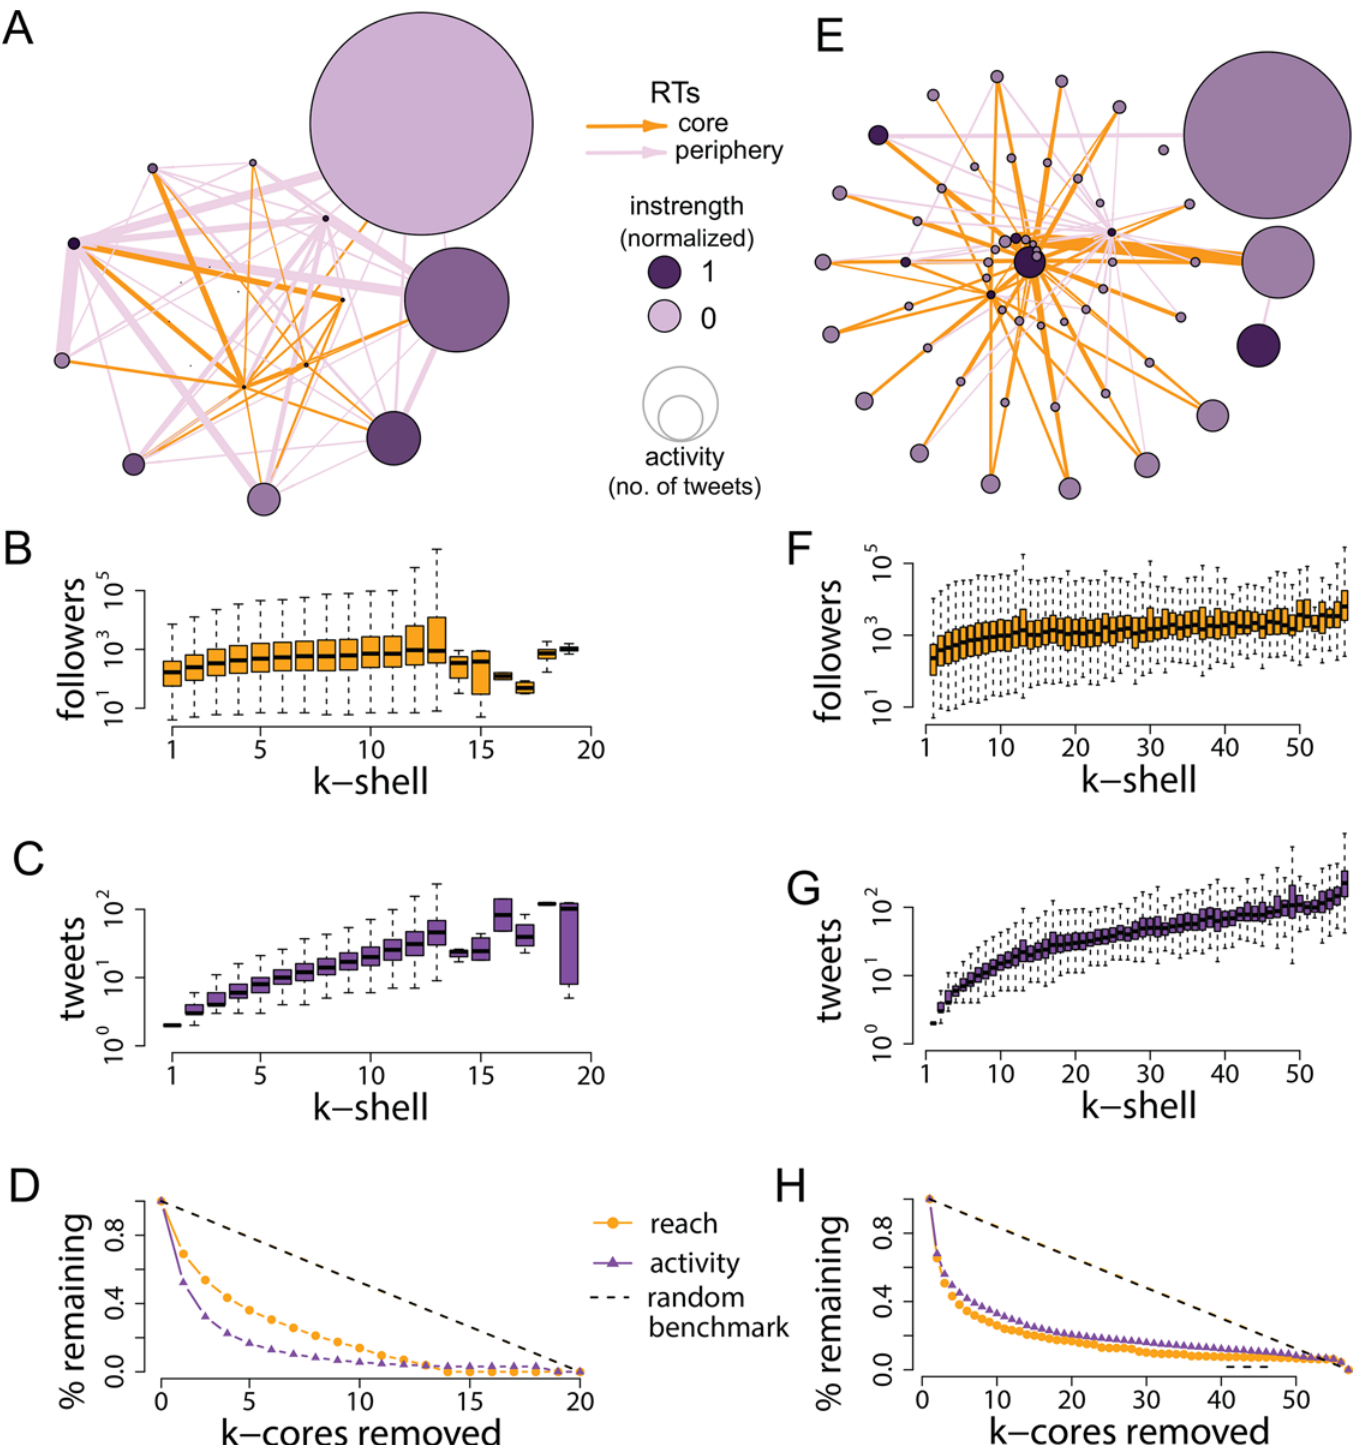
Fig 6. Audience size and activity levels across k -cores for the Oscars network (panels A-D) and the minimum wage network (panels E-H). Arcs with lower strength have been filtered to improve network visualization.